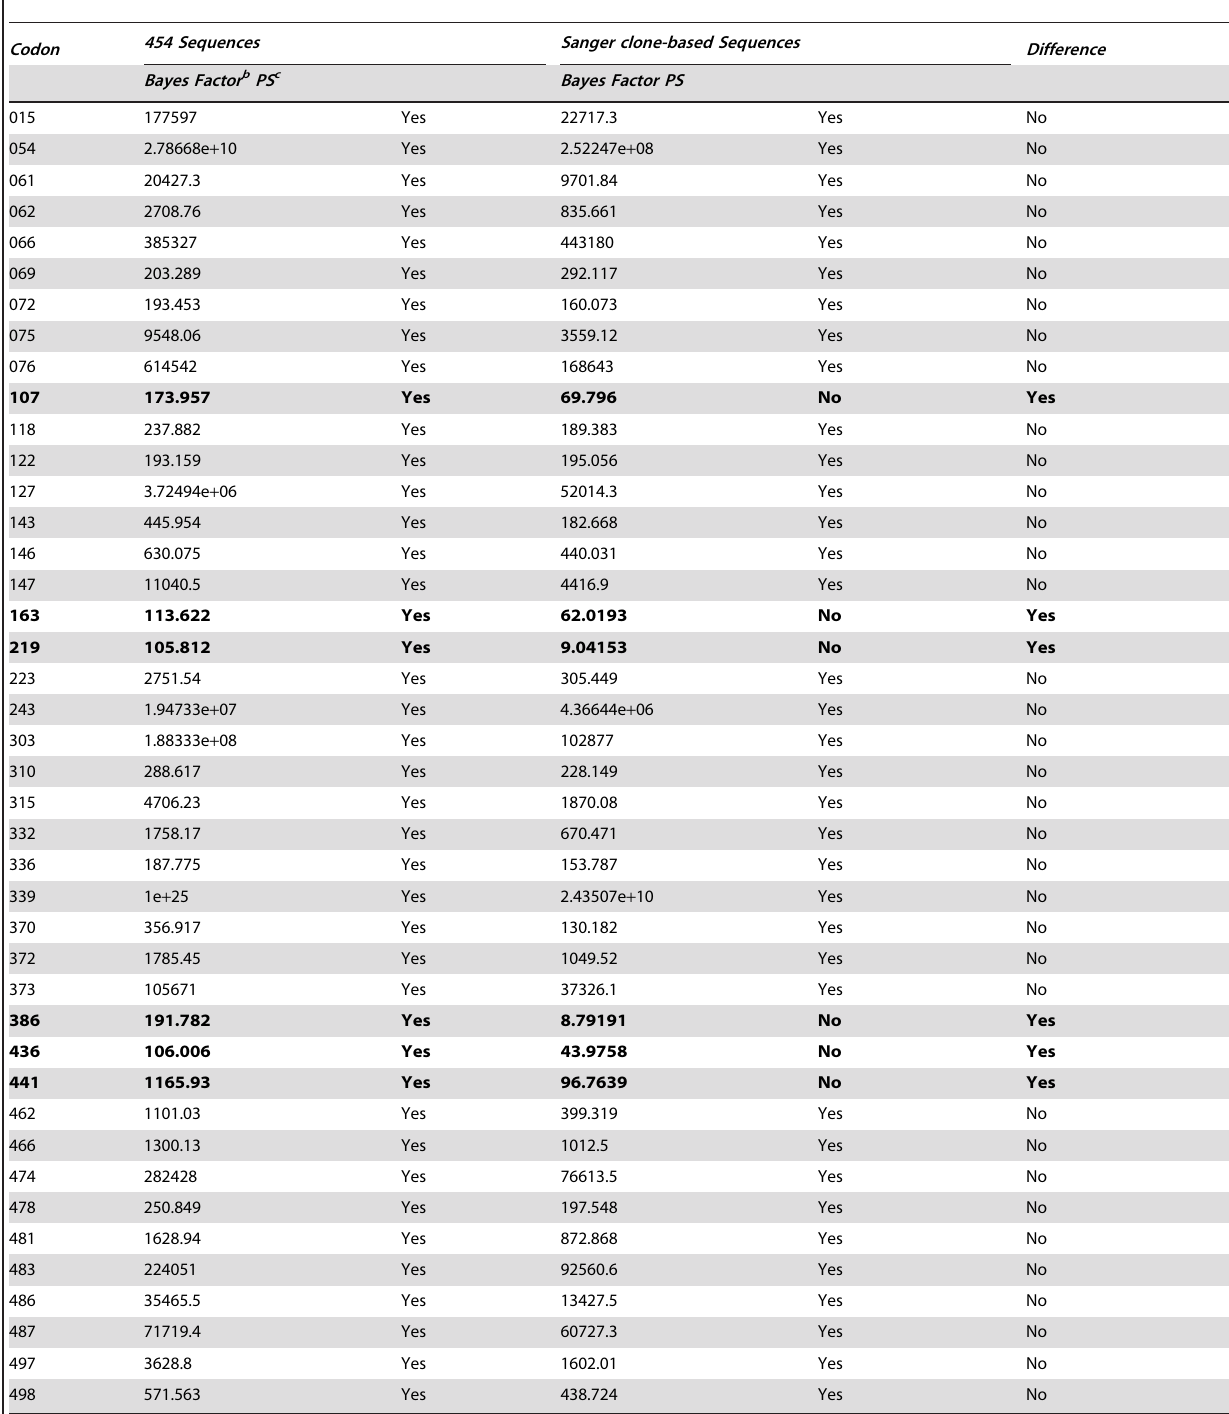
Forty-six amino acid consensus sequences (subtype A1) from 454 and Sanger clone-based methods are subjected to positive selection analysis by random effect likelihood (REL) method. The result of FEL analysis is given as Bayes factor and possibility of positive selection. The differences of positively selected sites identified between two amplified sequence populations are shown in bold. a : 454